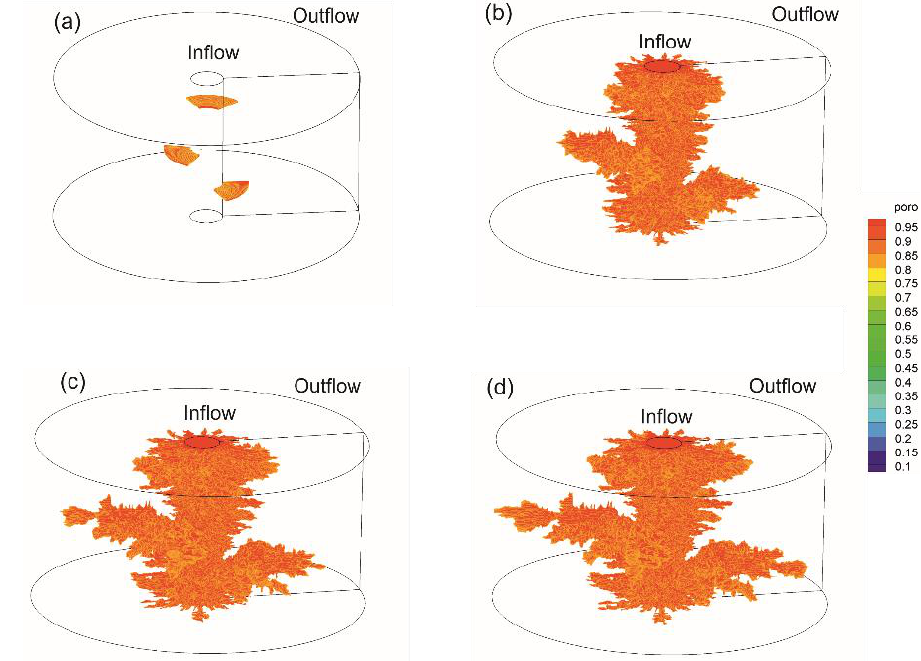
Figure 10. Temporal and spatial evolution of porosity. ( a ) initial condition; ( b ) 14.4 min; ( c ) 28.8 min; ( d ) 48 min (breakthrough).